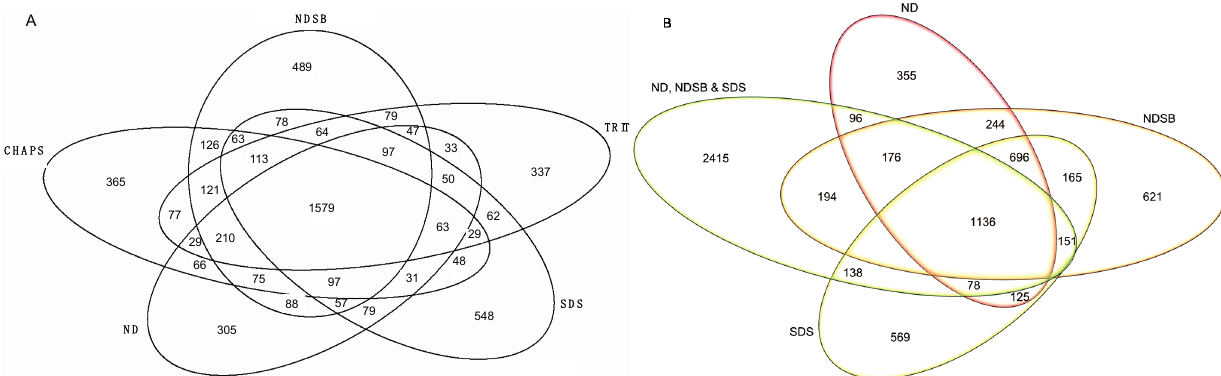
Figure 1. Venn diagrams of the number of Arabidopsis proteins identified using different buffer systems after OFFGEL fractionation. The lysis buffer containing 7 M urea and 2 M thiourea was supplemented with either no detergent (ND), 4% ( w / v ) 3-[(3-Cholamidopropyl)dimethylammonio]-1-propanesulfonate (CHAPS), 4% ( w / v ) non detergent sulfobetaine 201 (NDSB), 2% ( v / v ) Triton X-100 (TRIT), 1% ( w / v ) sodium dodecyl sulfate (SDS) or a two-step solubilization process consisting first in